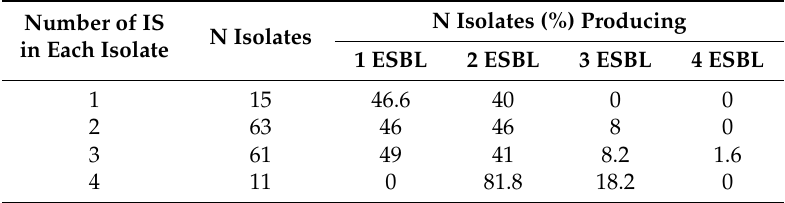
Table 5. Relationship between number of IS in each isolate and the number of expressed ESBLs. N Isolates (%) Number of IS N Isolates in Each Isolate